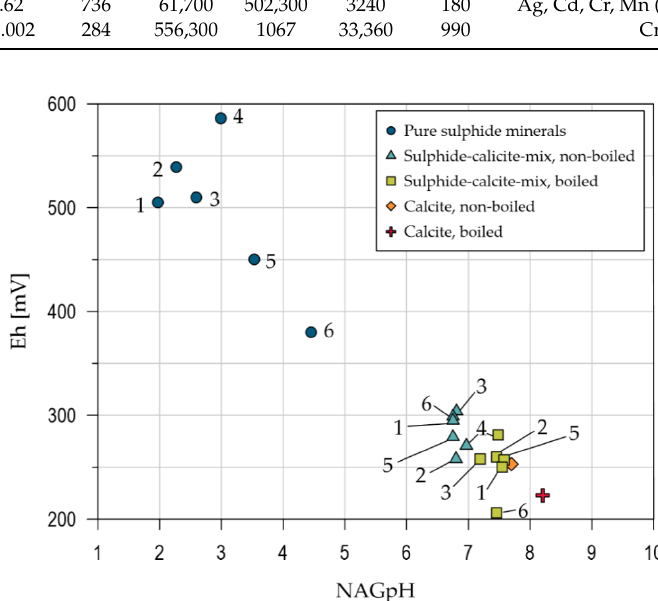
Figure 1. NAGpH versus Eh (mV) data for monomineralic and polymineralic samples tested by this study. 1 = stibnite; 2 = pyrite; 3 = arsenopyrite; 4 = chalcopyrite; 5 = galena; 6 = sphalerite.